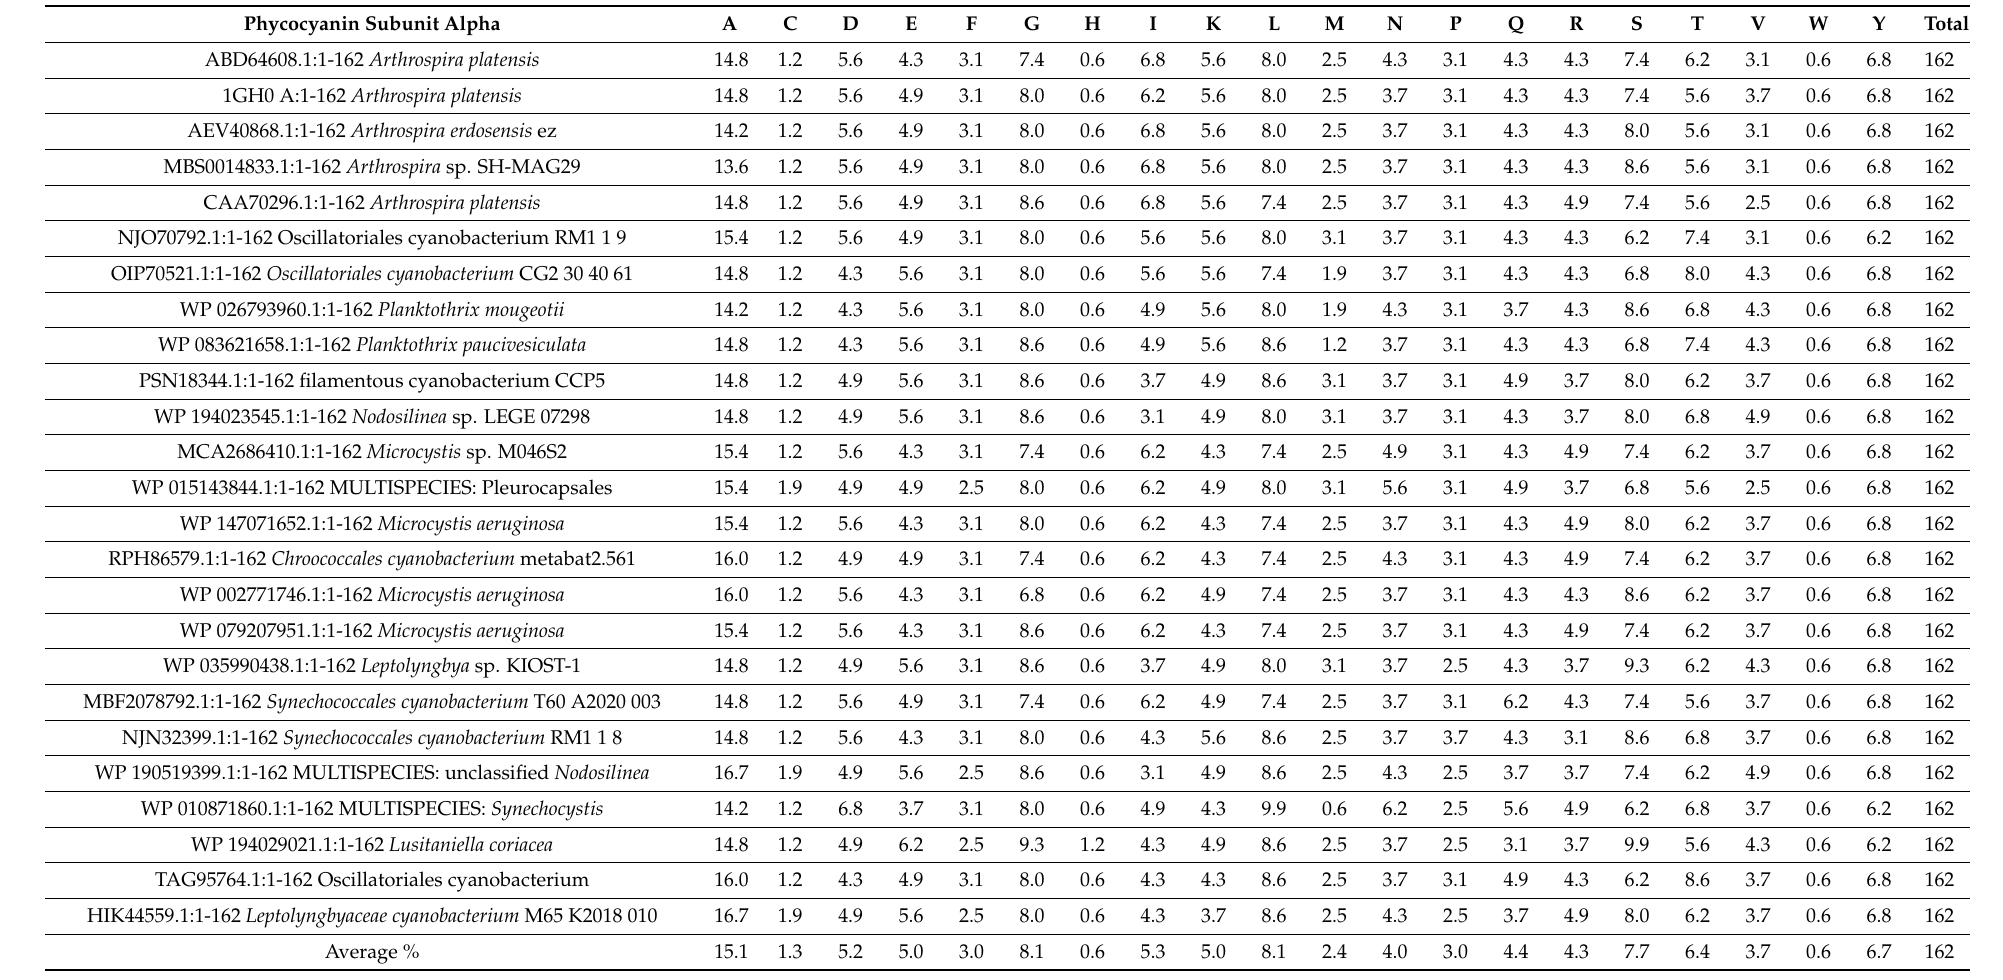
Table 5. The frequencies of amino acids (%) in phycocyanin subunit alpha protein sequences of 25 cyanobacterial species, including A. platensis strains and variants, as calculated using